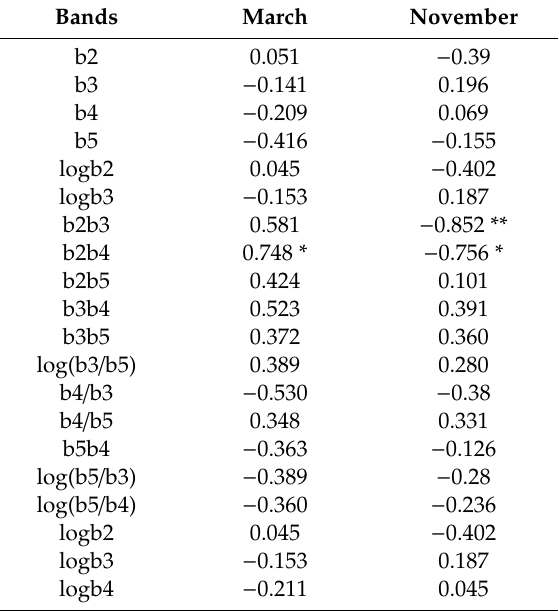
Table 4. Correlation between bands and reflectance for March and November 2014.